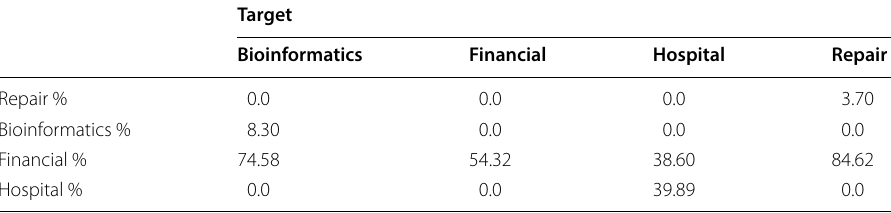
Table 3 Cross domain belonging measures of different workflow